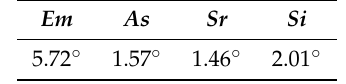
Table 3. Mean direction offset to dy per auralization technique over all tested beam directions ϕ S . Em